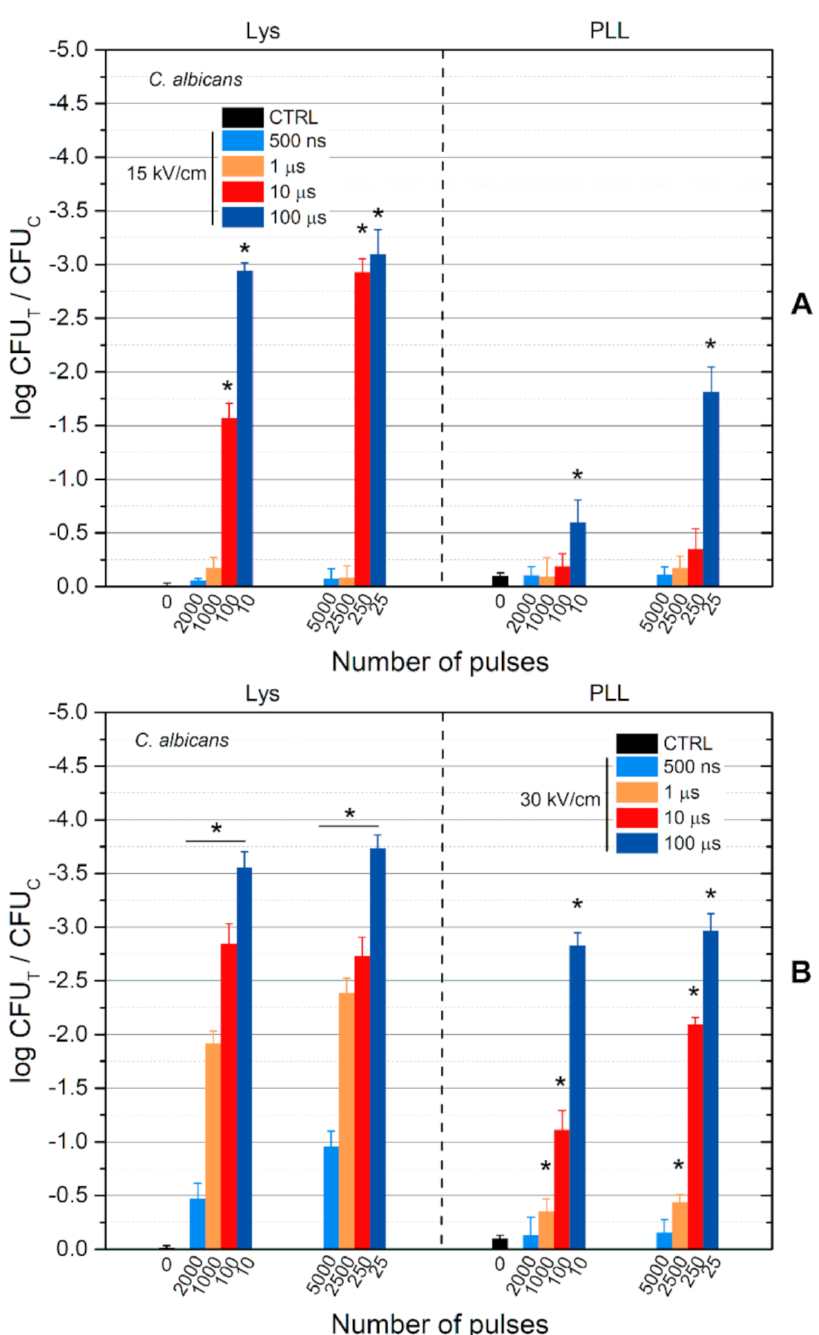
Figure 3. The antimicrobial efficacy of L-lysine and poly-L-lysine with pulsed electric field treatment against C. albicans , where ( A ) 15 kV/cm treatment; ( B ) 30 kV/cm treatment. Asterisk (*) represents statistically significant ( p < 0.05) difference versus Lys or PLL treatment, respectively. CTRL—samples with Lys or PLL without PEF